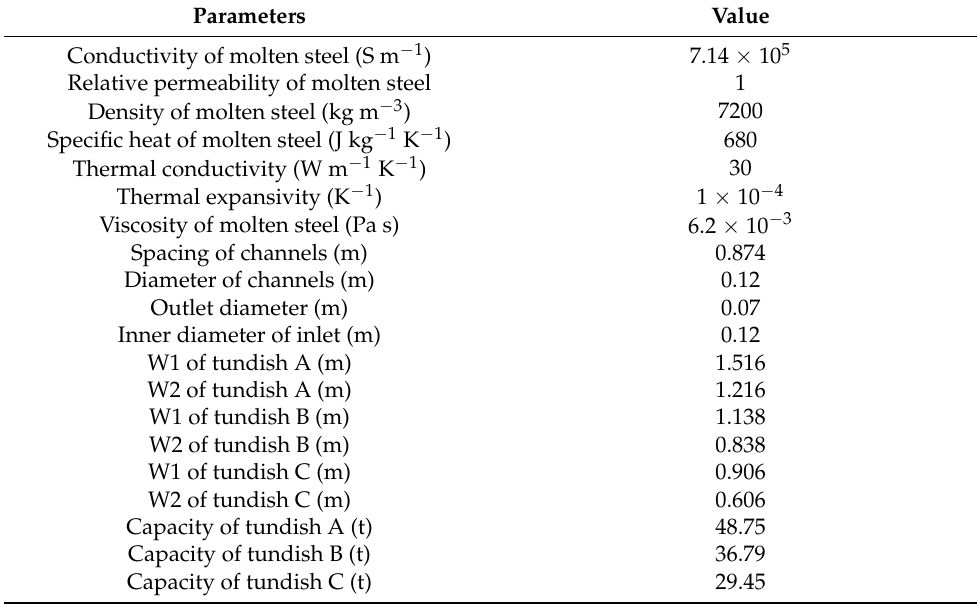
Figure 1. Configuration and coordinate system. Unit is in millimeter. Table 1. Dimensions and other parameters.